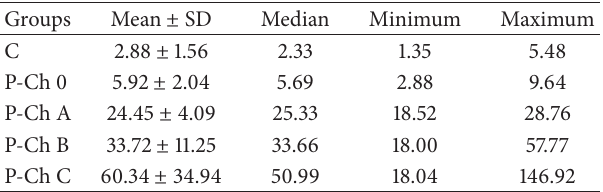
The univariate logistic regression analysis showed that levels of IL-1 𝛼 , IL-6, and HGF had influenced liver cirrhosis risk ( 𝑝 < 0.001 ) (Table 6).